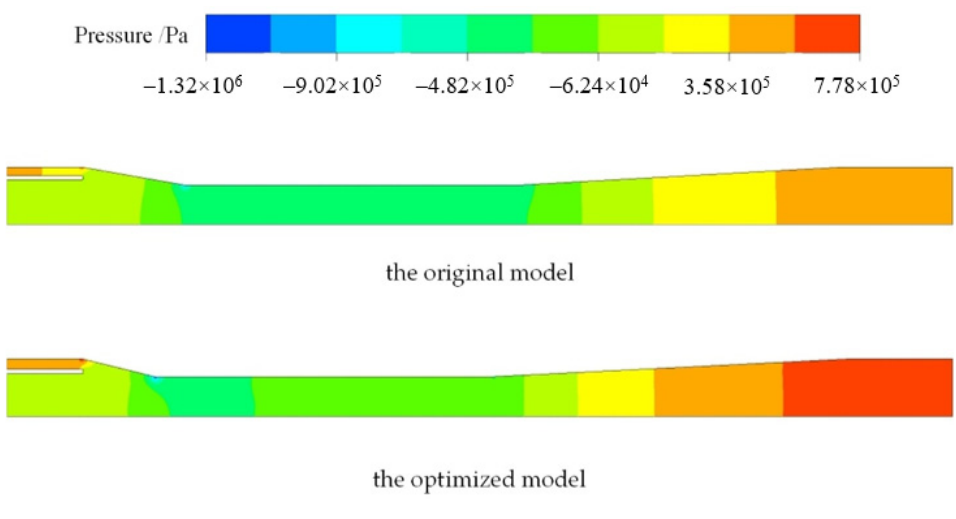
Figure 12. Pressure distribution of annular jet